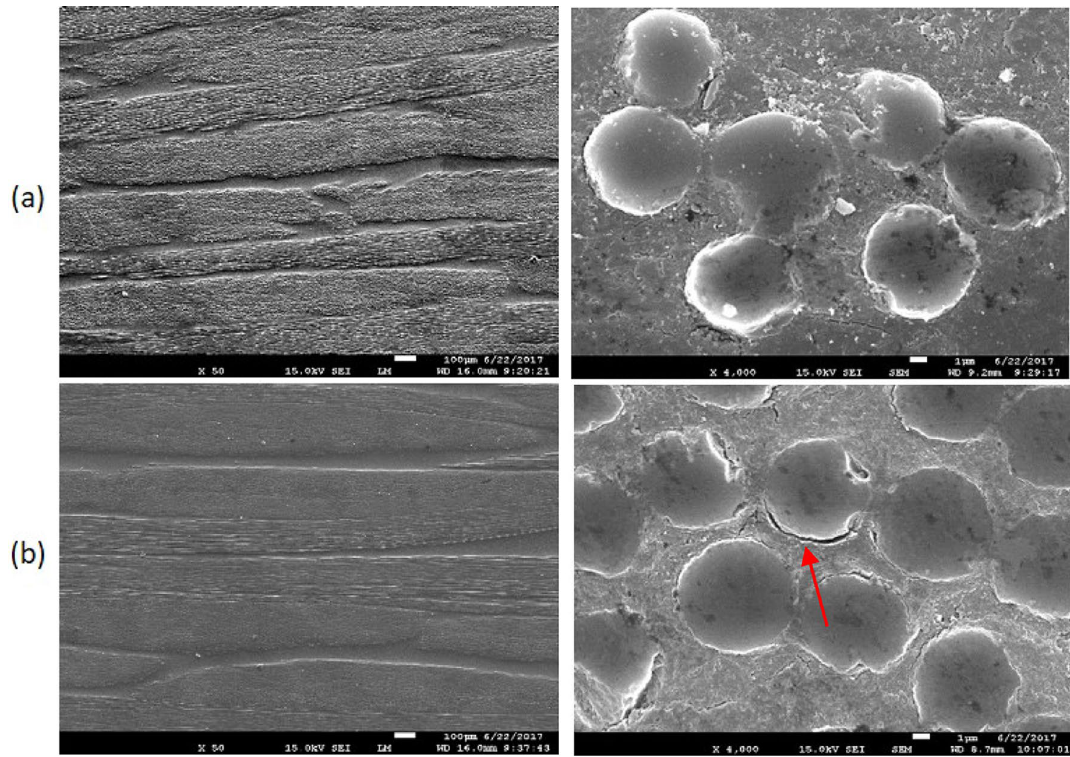
Figure 5. SEM images of cross-section of ( a ) virgin and ( b ) recycled composites.